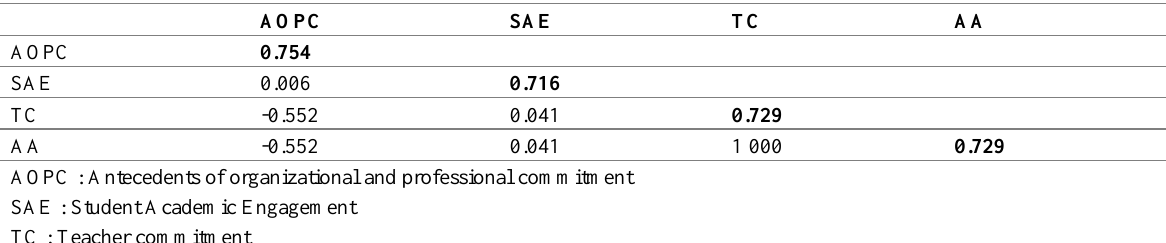
Table 6: Represents the result of the regression (Discrimiant Validity)